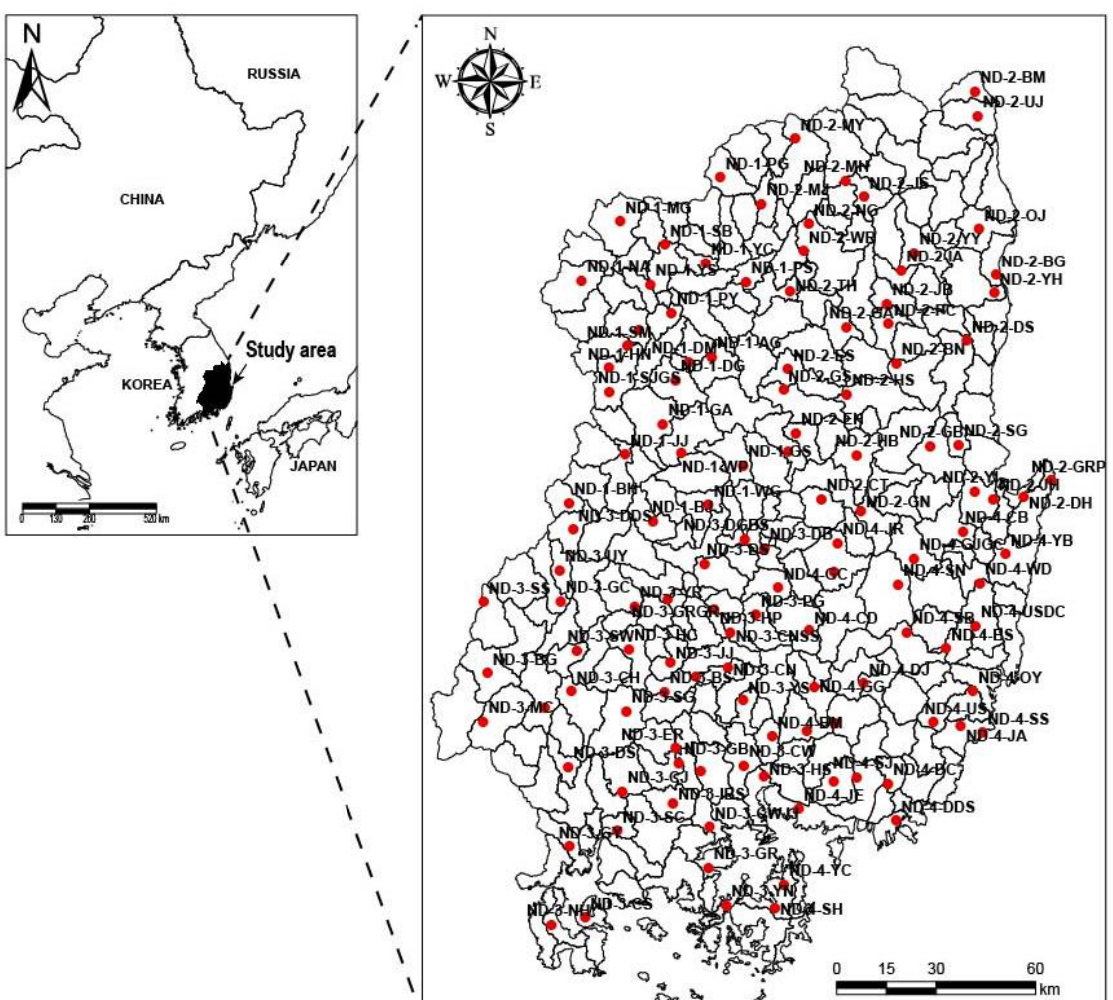
Figure 1. Location of the wells of the national groundwater monitoring network and the standard subwatersheds in the Nakdong River watershed.